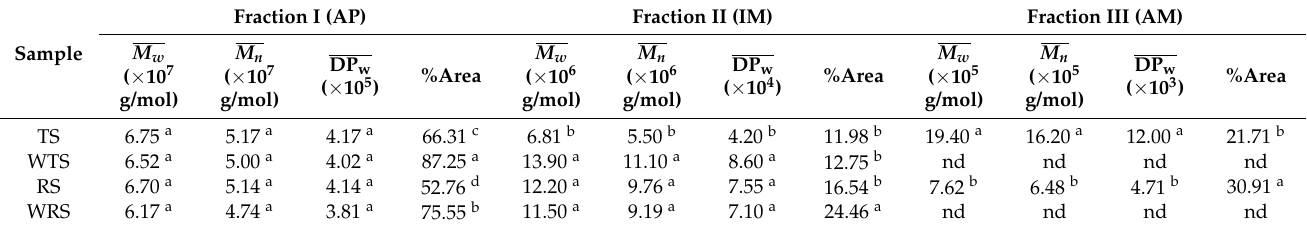
Table 2. Molecular distribution and AM/IM/AP ratio of